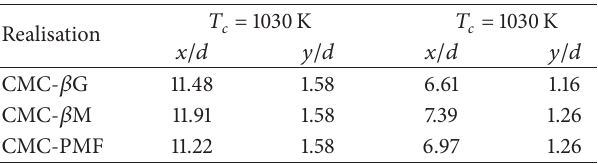
Table 2: Locations of the stabilisation points obtained using the three CMC realisations with the coflow temperatures 1030K and 1060